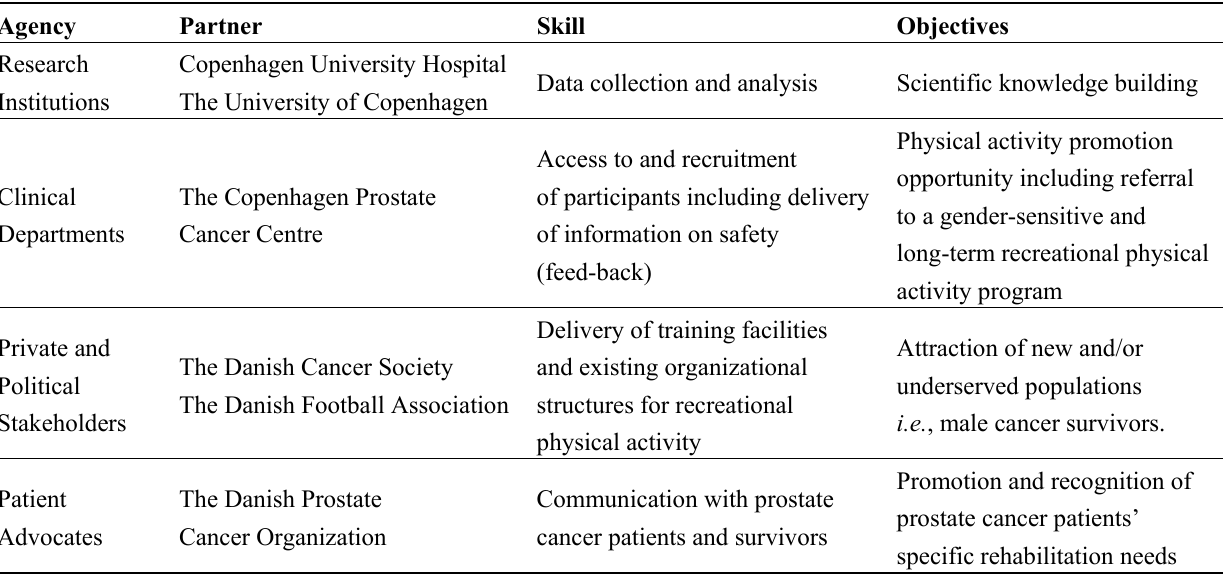
Table 1. Partners, skills and